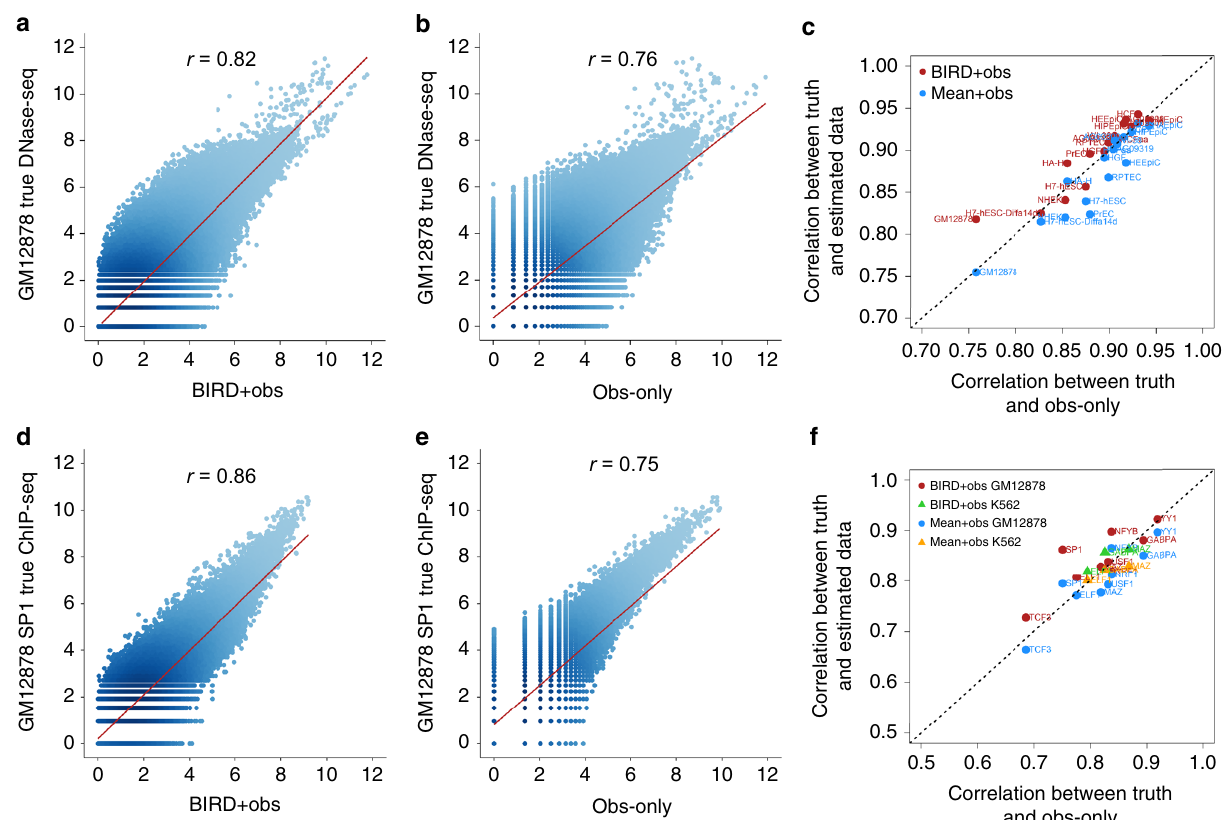
Fig. 8 BIRD predictions used as pseudo-replicates to improve DNase-seq and ChIP-seq data analyses. The observed signal from one sample ( “ obs-only ” ) in a test cell type was combined with BIRD predictions to produce the integrated signal ( “ BIRD + obs ” ). Signals before and after integration are compared with the observed signal from another sample from the same cell type ( “ truth ” ). a – c DNase-seq. a Correlation ( r ) between the “ truth ” and “ BIRD + obs ” (i.e., the integrated signal) in GM12878. Each dot is a genomic locus. b Correlation between the “ truth ” and “ obs-only ” (i.e., the original signal without integrating BIRD) in GM12878. c The same analyses were done for 16 test cell types. Red dots in the scatterplot compare the P – T correlation r for BIRD + obs vs. r for obs-only in the 16 cell types. BIRD + obs outperformed obs-only in 12 of 16 test cell types. As a control, BIRD was replaced by the mean DH pro fi le of training cell types. Blue dots show the P – T correlation r for mean + obs vs. r for obs-only in the 16 test cell types. Mean+ obs did not improve over obs-only. d – f ChIP-seq. d Correlation between the “ truth ” and “ BIRD + obs ” for SP1 in GM12878 at SP1 motif sites. e Correlation between the “ truth ” and “ obs-only ” for SP1 in GM12878 at SP1 motif sites. f The same analyses were done for nine TFs in GM12878 (circles) and three TFs in K562 (triangles). Once again, BIRD + obs outperformed obs-only in 9 of 12 cases (red and green), but mean + obs did not improve over obs-only (blue and δ j j > 1 as the cutoff yielded a good empirical validation rate (15/22 = 68%). The 76,495 differential DHSs are generated using this cutoff. They represent a signi fi cant amount of new information generated by BIRD.